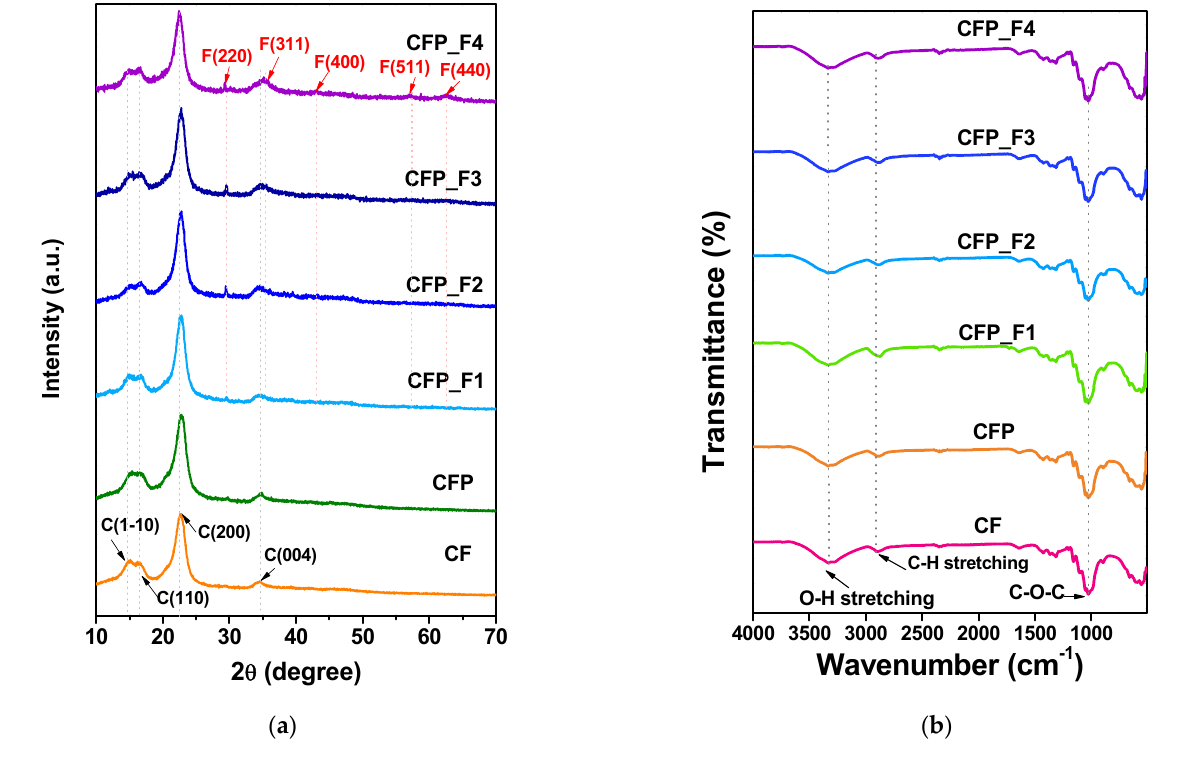
Figure 3. ( a ) XRD and ( b ) FTIR spectra of CF, CFP, CFP_F1-F4. Chemical structures of the CF, CFP, and CFP_F1-F4 were studied by FTIR analysis. FTIR spectra of pristine CF, CFP, and CFP_F1-F4 are displayed in Figure 3b. The three main characteristic peaks of cellulose in FTIR spectra were observed in all specimens at 1030, 2895, and 3330 cm − 1 . The broad peak at 3330 cm − 1 and the peak at 2595 cm − 1 correspond to the stretching vibration of O–H bonds and C–H bond in polysaccharide [29,30]. The peak at 1030 is associated with the C–O–C pyranose skeleton ring vibration of cellulose molecule [31]. In addition, the peaks at 610 and 550 cm − 1 were attributed to the C–H bend from lignin molecules [32]. However, the peak of Fe–O bonding at around 570 cm − 1 [33] was not observed in CFP_F1-F4, which could be due to the superposition by the lignin band. TENG performances of the fabricated CF paper-based TENGs were tested with a Teflon sheet as a contact tribonegative material. The working mechanism of the fabricated TENG under a single electrode mode is illustrated in Figure 4. The electrical output is generated by a combination of electrification and electrostatic induction effects. When the surfaces of two different materials are contacted (state I), electrons are transferred between them due to the difference in their chemical potentials. Depending on the tendency to gain/lose electrons, surface charges or triboelectric charges with different signs are formed on the two surfaces. Since Teflon is known as the most tribonegative material, negative surface charges are formed on its surface and positive ones are formed on the CF